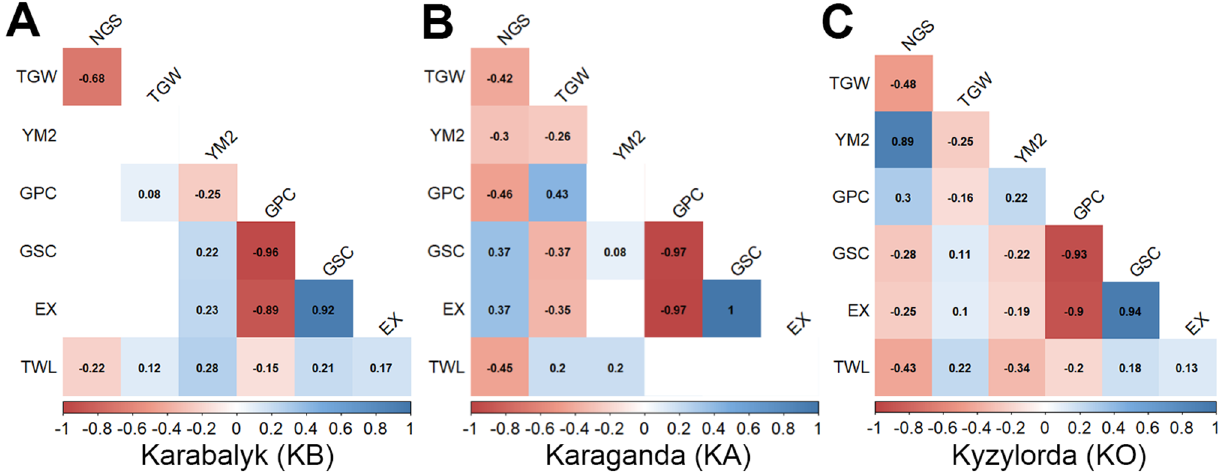
Figure 3. Correlation coefficients ( r ) among grain quality and yield-related traits. ( A ) Karabalyk or KB. ( B ) Karaganda or KA. ( C ) Kyzylorda or KO. GPC—grain protein content (%); GSC—grain starch content (%); EX—extractivity (%); TWL—grain test weight per liter (%); NGS—number of grains per spike (pcs.); TGW—thousand-grain weight (g); YM2—yield per m 2 (g/m 2 ). Cells with significance at p < 0.05 are highlighted in color: the directions of correlations are denoted in color, with red indicating negative and blue indicating positive. Color intensity increases with the decrease in p .